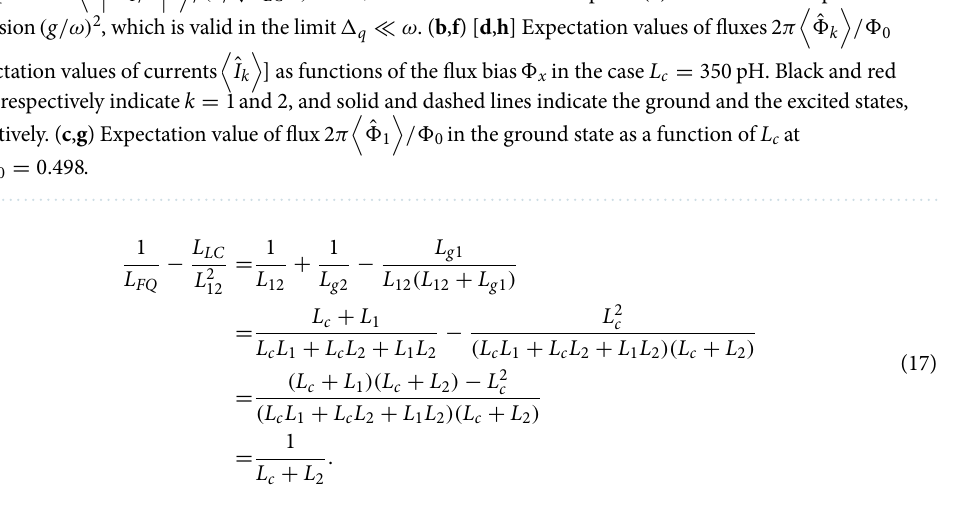
� k /� 0 ˆ (cid:31) (cid:30) 350 pH. Black and red =